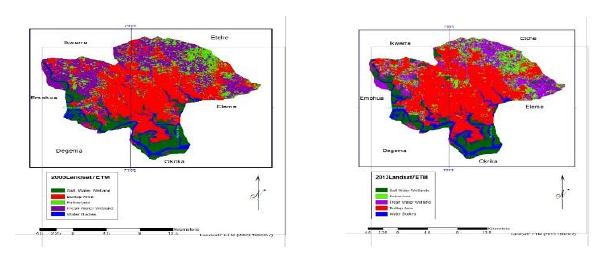
Figure 4: 2003 Landsat7 ETM Image Figure 5: 2013 Landsat7 ETM . Image